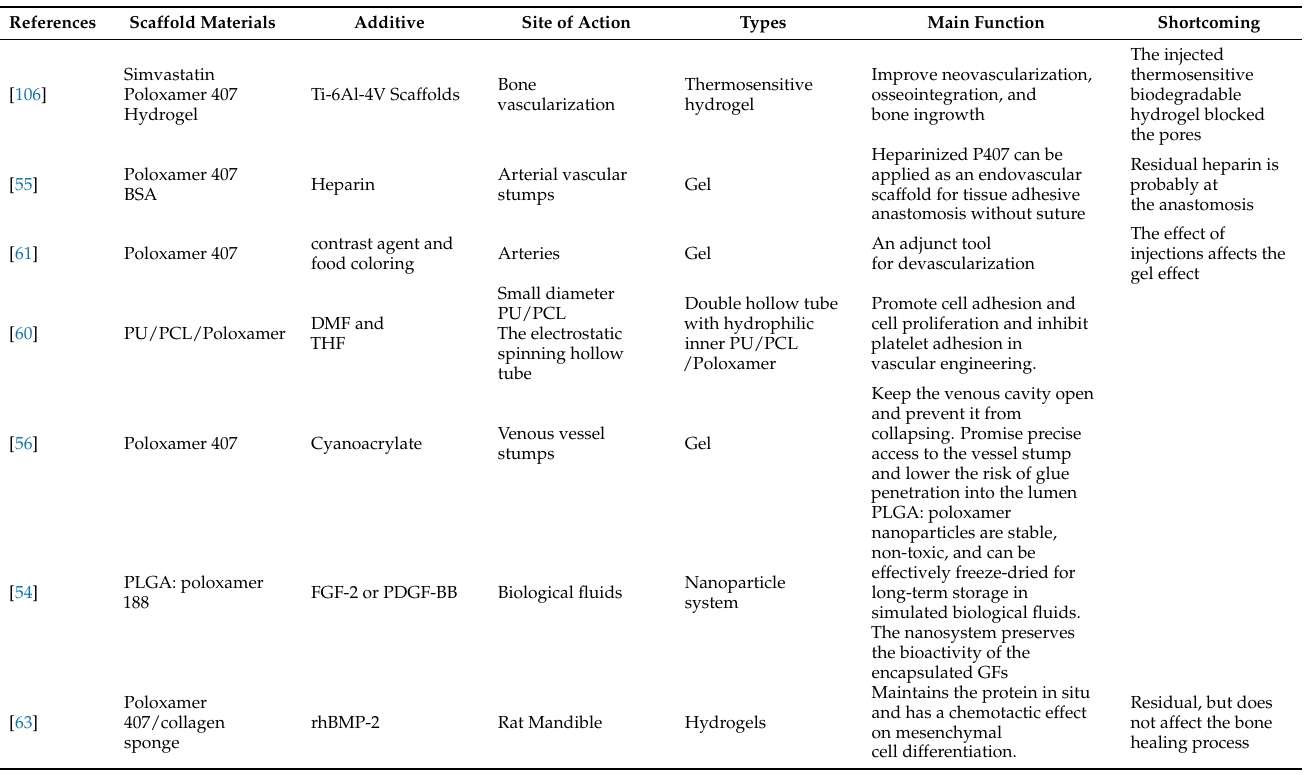
Table 2. Poloxamers in tissue engineering